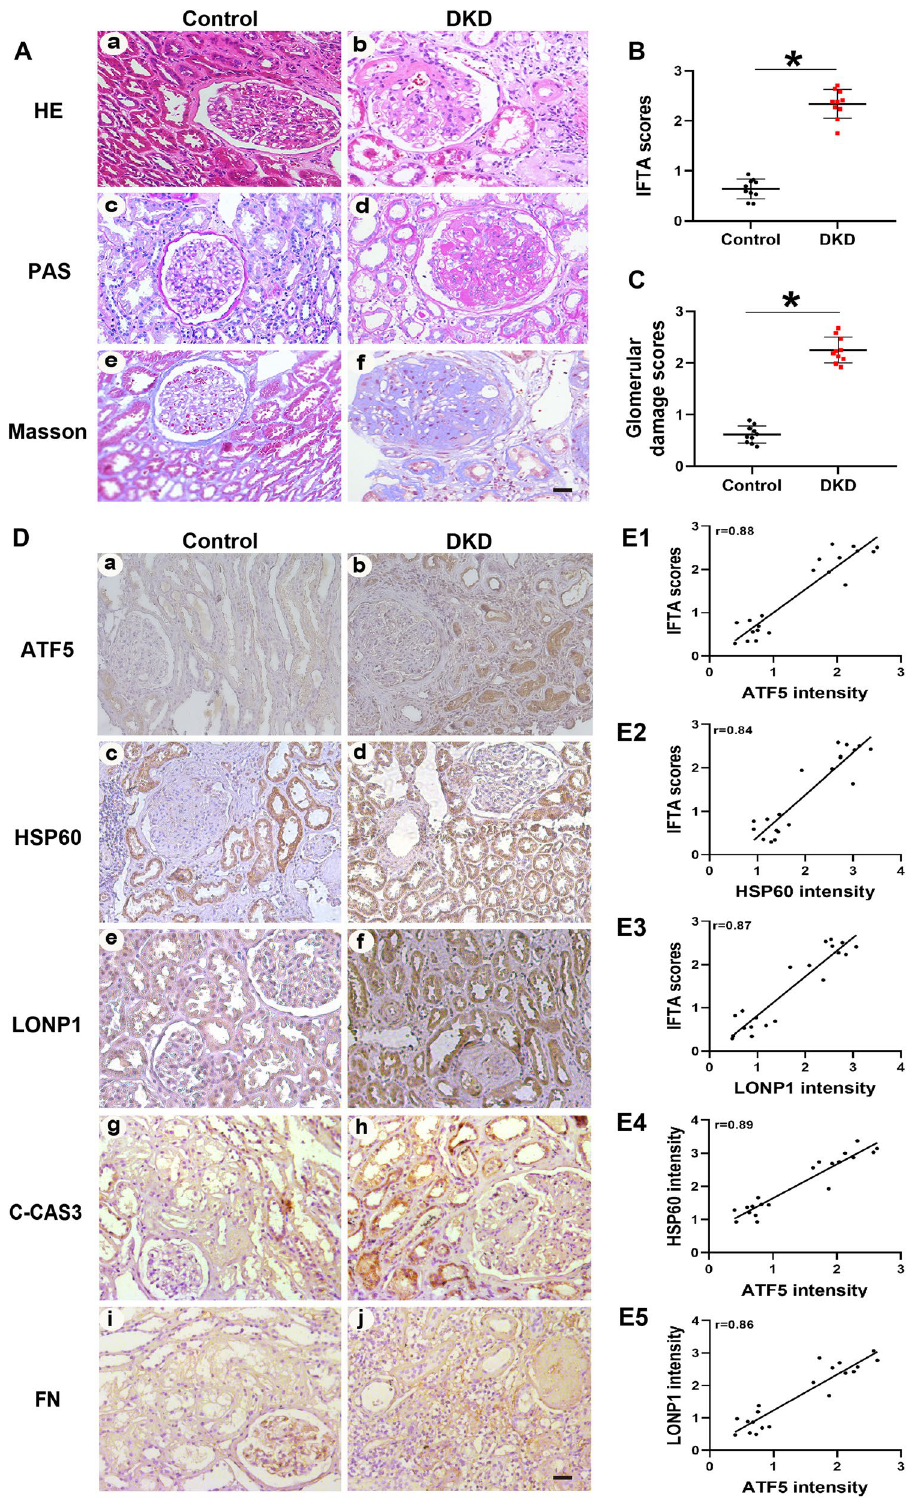
Fig. 1 Increased ATF5/HSP60/LONP1 expression positively correlates with tubulointerstitial damage in kidney biopsy sections of DKD patients. A HE, PAS and Masson staining of the histological changes in kidney biopsies of DKD patients. B, C Quantitative analysis of interstitial fibrosis and tubular atrophy (IFTA) scores and glomerular injury. D IHC staining of ATF5/HSP60/LONP1, C-CAS3 and FN in kidney biopsy sections of DKD patients. E1–E3 The correlations of ATF5, HSP60 and LONP1 expression levels with IFTA scores. E4–E5 The correlations of HSP60, LONP1 with ATF5 expression in the kidney of type 2 DKD patients. Scale bar: 25 μm. All data are presented as means SD; *p < 0 .05 vs control group. r: correlation coefficient. n ± =